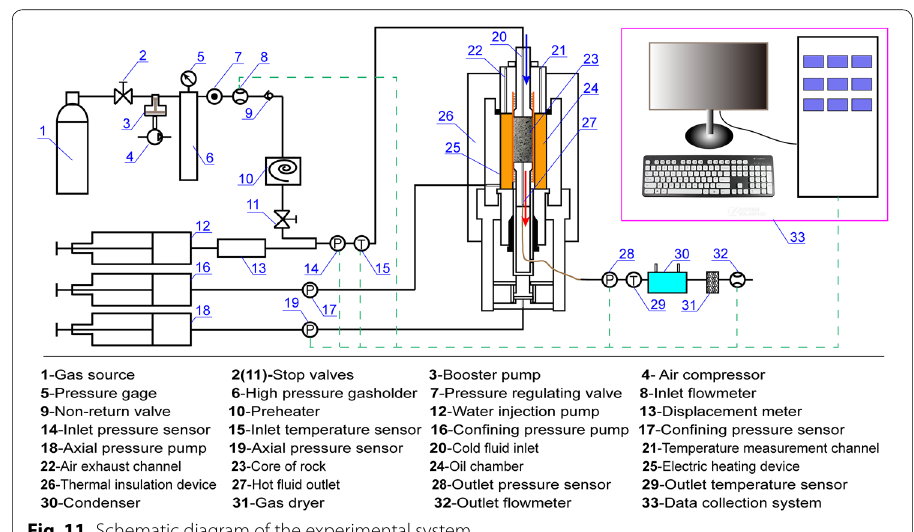
Fig. 11 Schematic diagram of the experimental